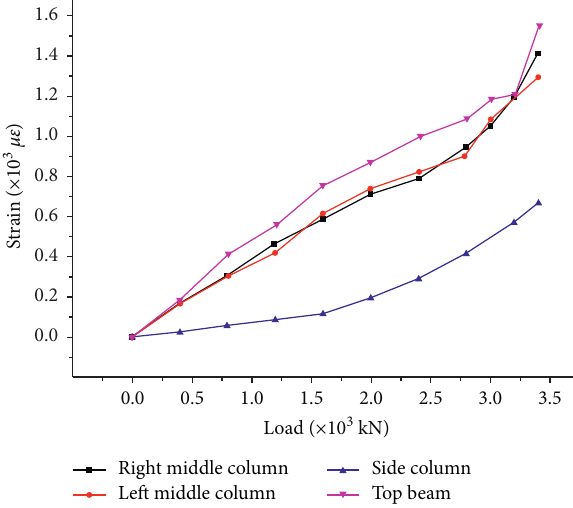
Figure 15: The strain-load curve of reinforcement in the top beam and concrete in the columns.